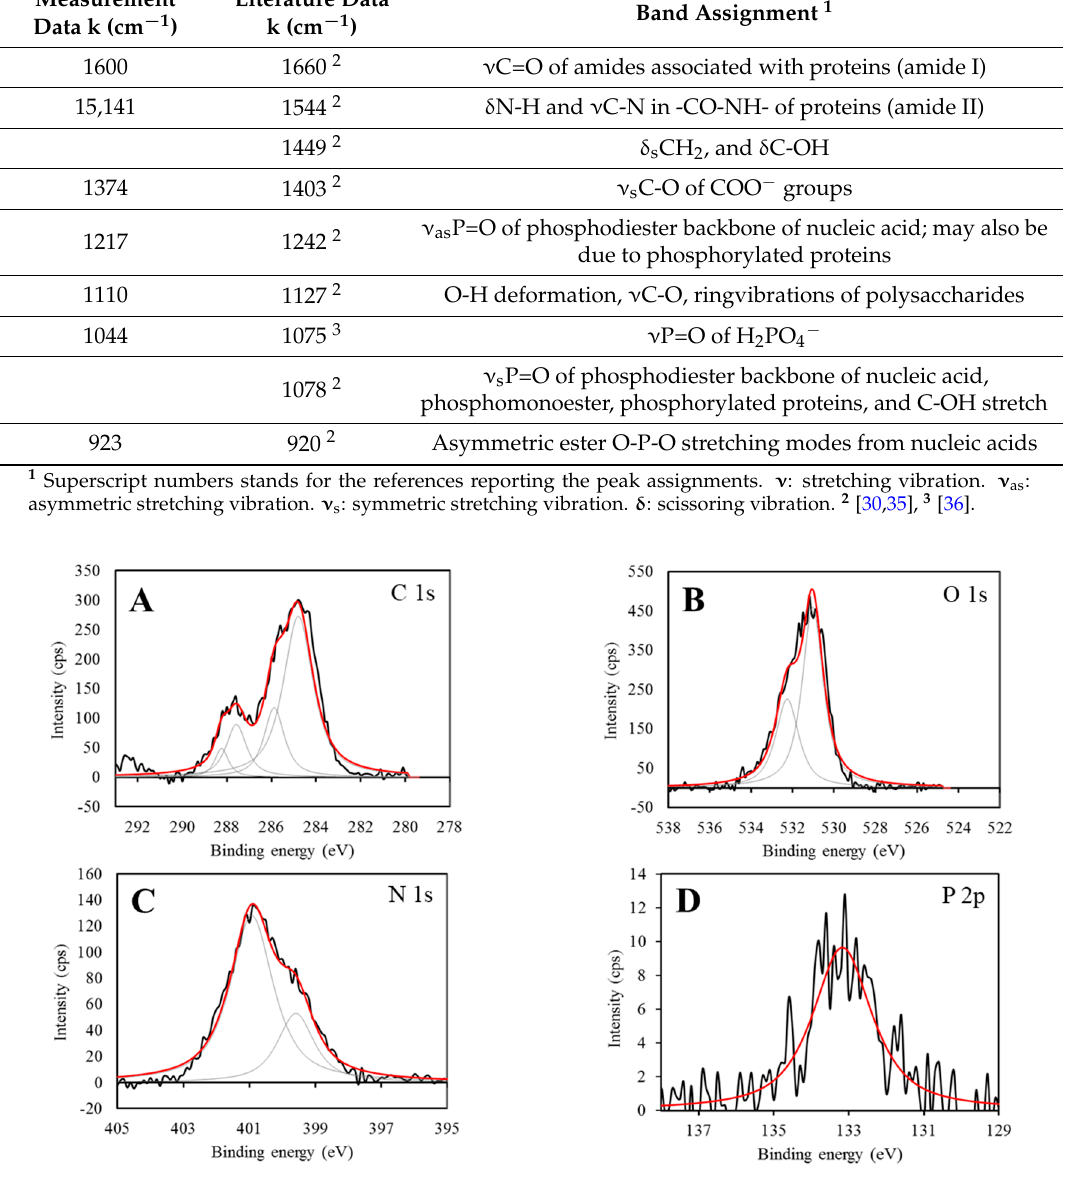
Figure 2. XPS spectra of narrow scans over C 1s ( A ), O 1s ( B ), N 1s ( C ), and P 2p ( D ) peak regions in the pristine EPS prepared at pH 6. the pristine EPS prepared at pH